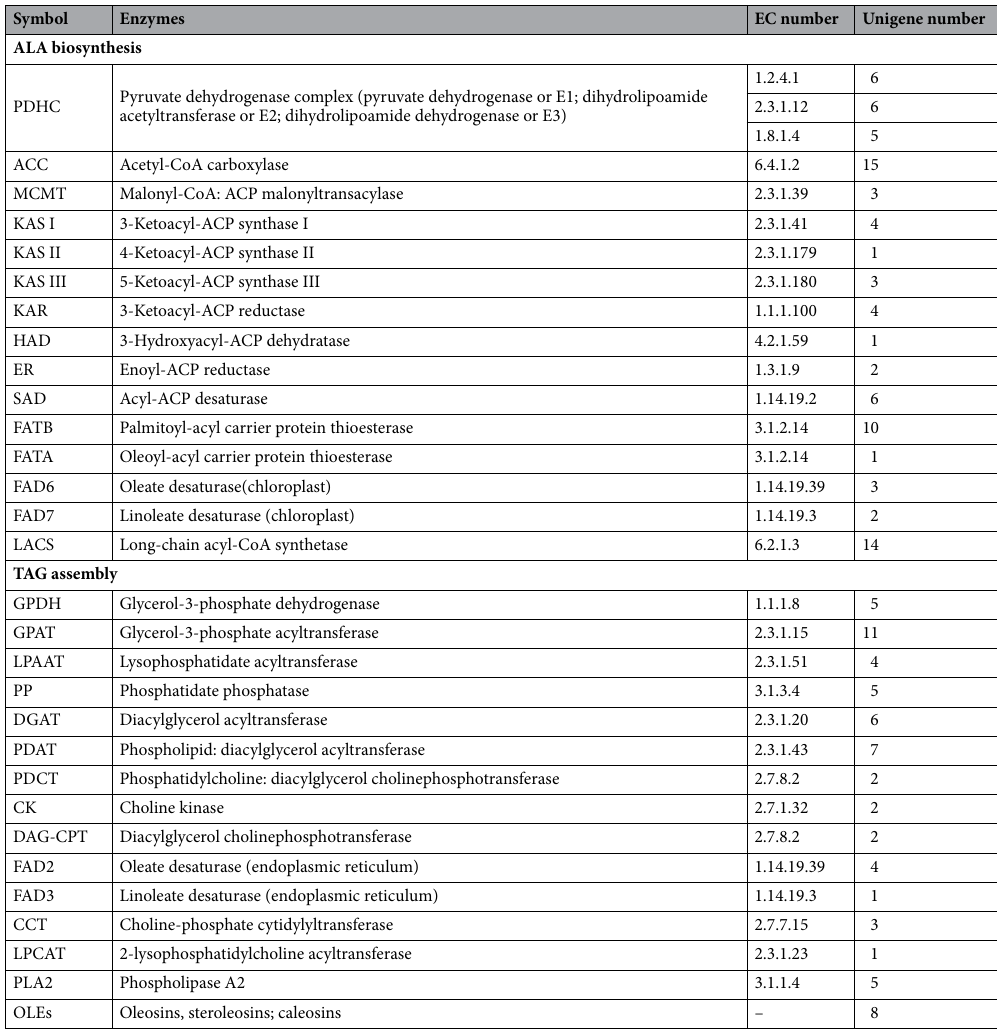
Table 3. Key enzymes related to ALA biosynthesis and TAG assembly identified by annotation of the P. volubilis seed